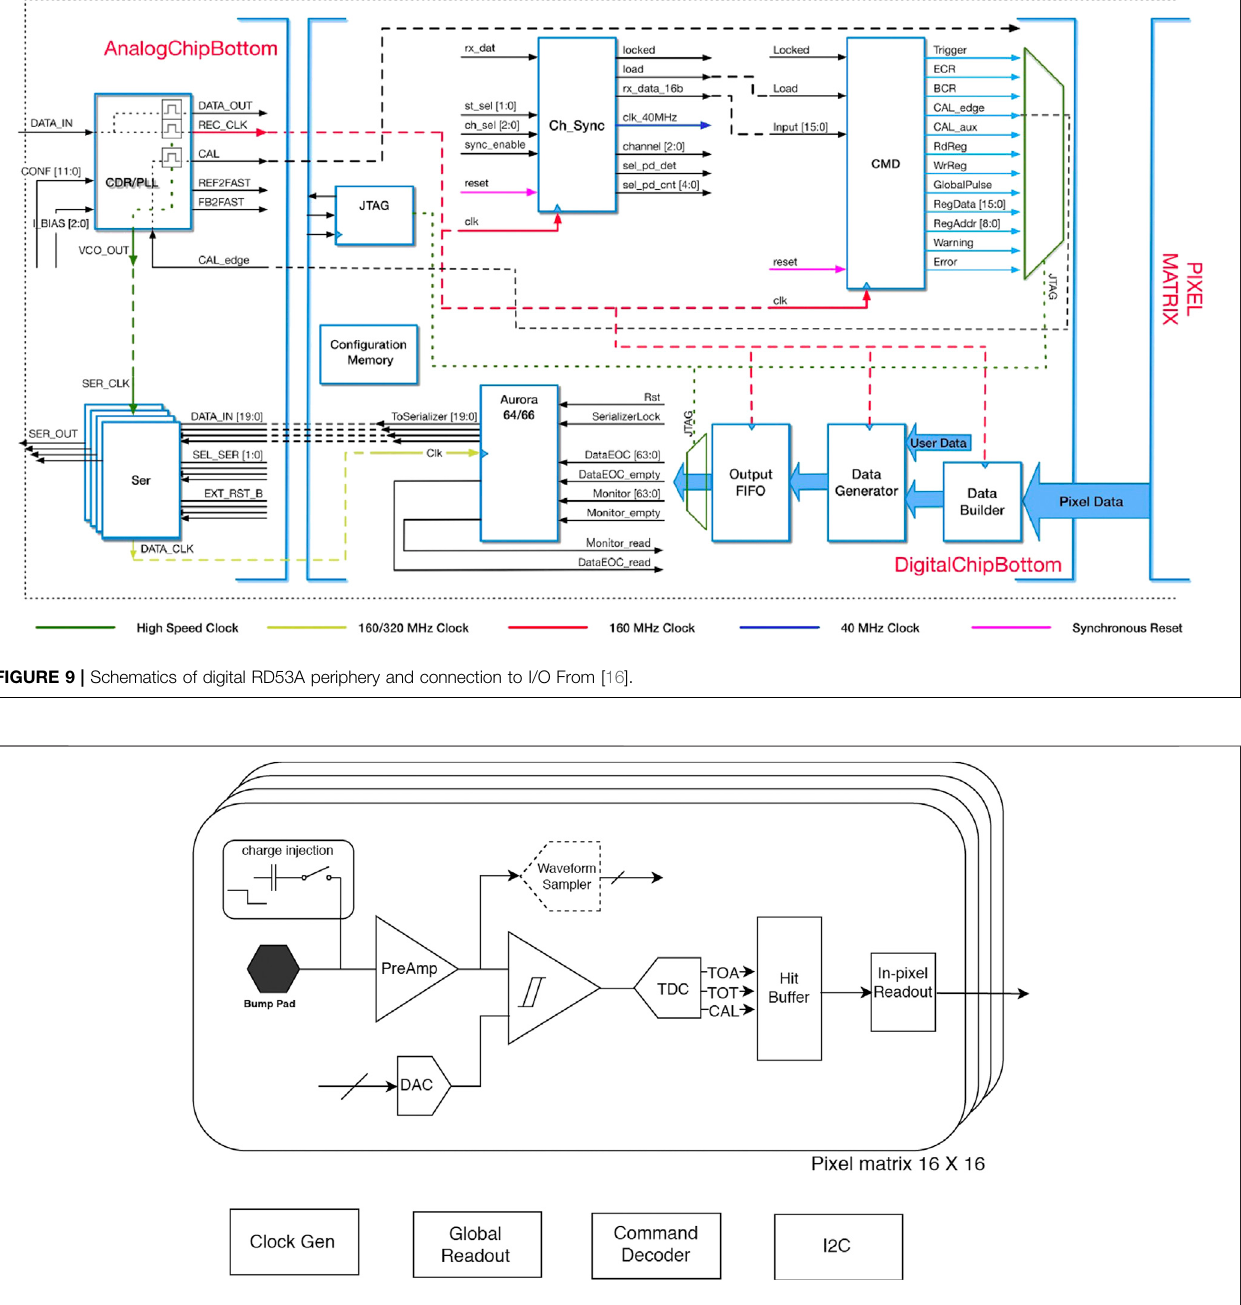
FIGURE 10 | Schematics of ETROC From